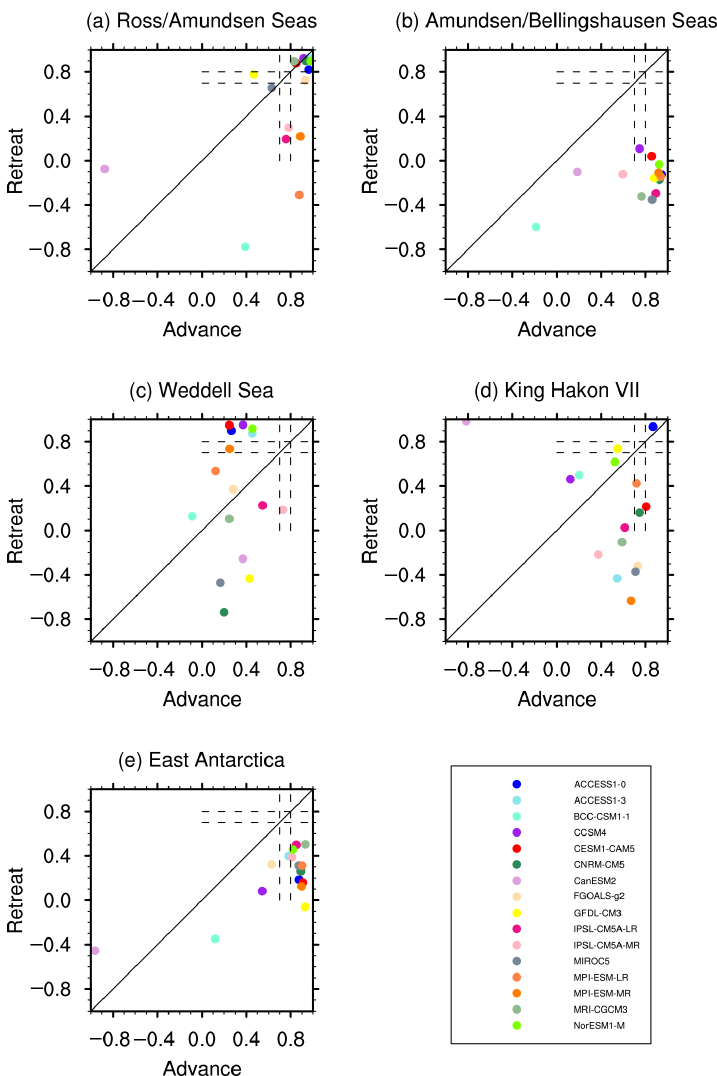
Figure 2. Pattern correlation values comparing observations and CMIP5 piControl ensemble correlation maps of SLP and SIE in the (a) Ross/Amundsen seas; (b) Amundsen/Bellingshausen seas; (c) Weddell Sea; (d) King Hakon VII; and (e) East Antarctica sectors. Dotted lines at 0.7 and 0.9 show the point at which the coefficient of determination, r 2 , is equal to 50 or 80%, respectively. The diagonal line indicates where correlations for both seasons would be in